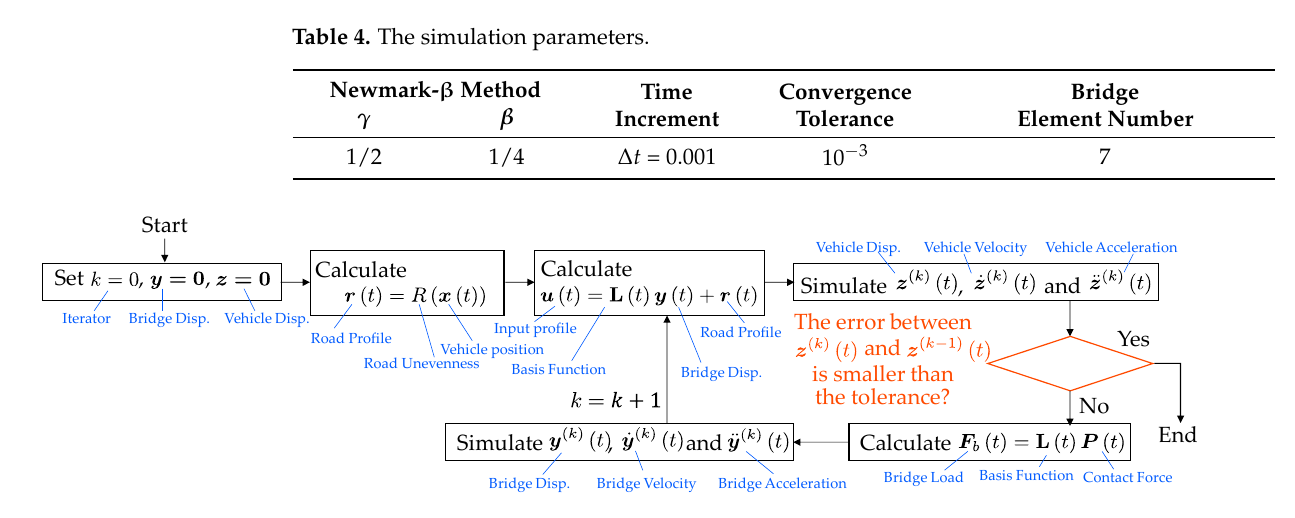
Figure 4. The algorithm of PRE simulation.